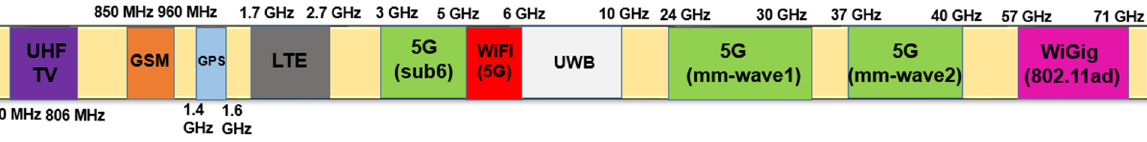
Figure 2. Frequency spectrum distribution in commercial use today.